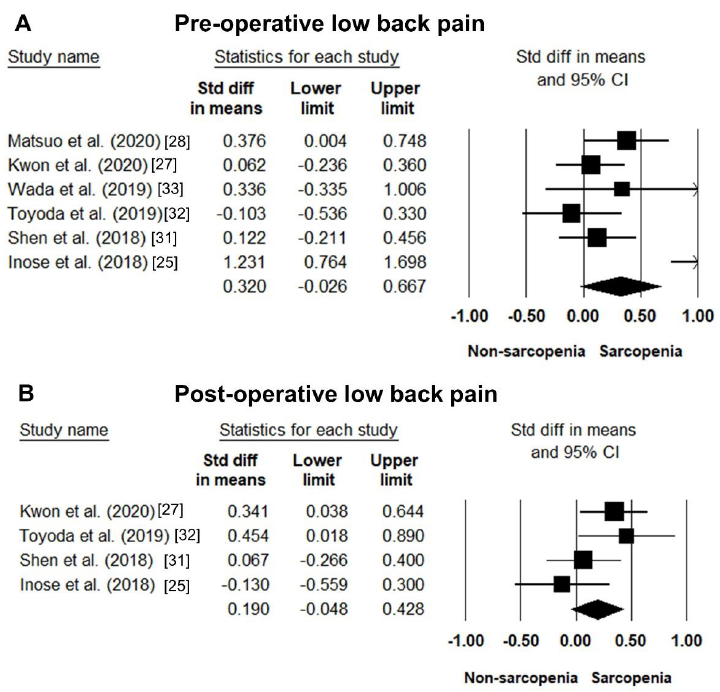
Figure 4. Forest plot of the standardized mean differences of the pre-operative ( A ) and post-operative ( B ) low back pain between patients with and those without sarcopenia. Std diff: standardized difference.